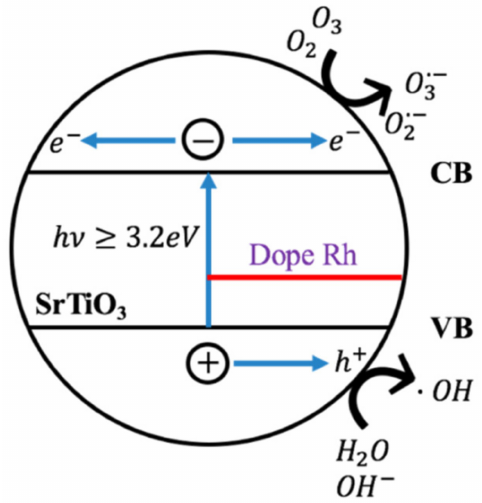
Figure 1. Mechanism of ozone